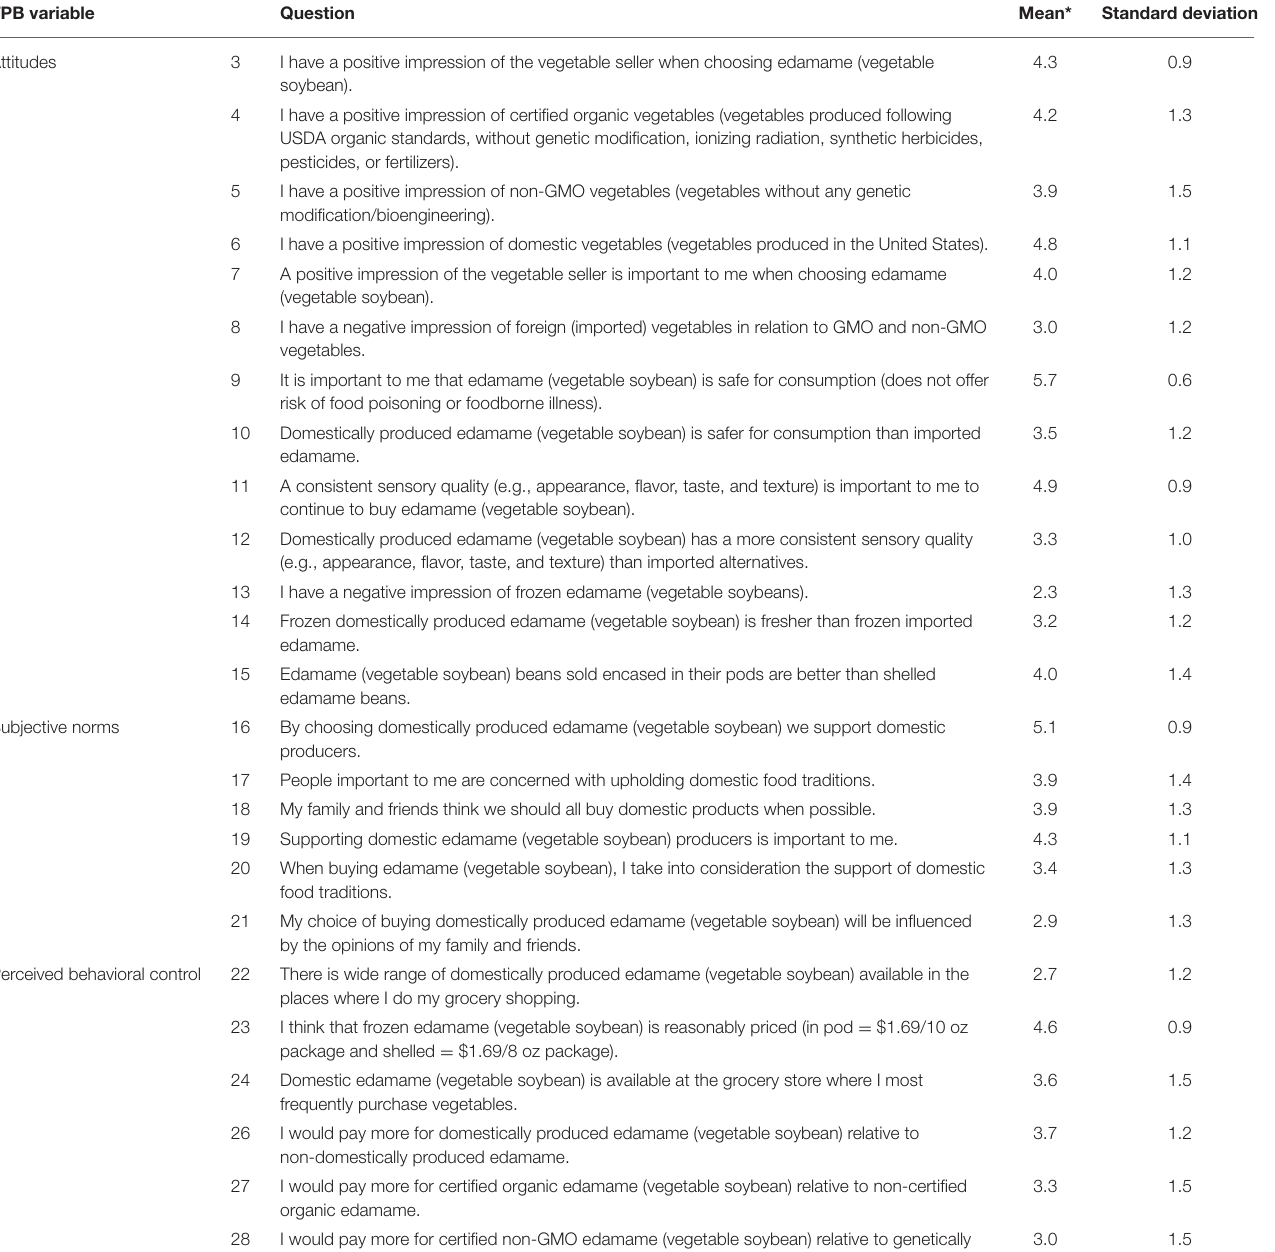
TABLE 3 | Mean likeness and standard deviation of theory of panned behavior (TPB)